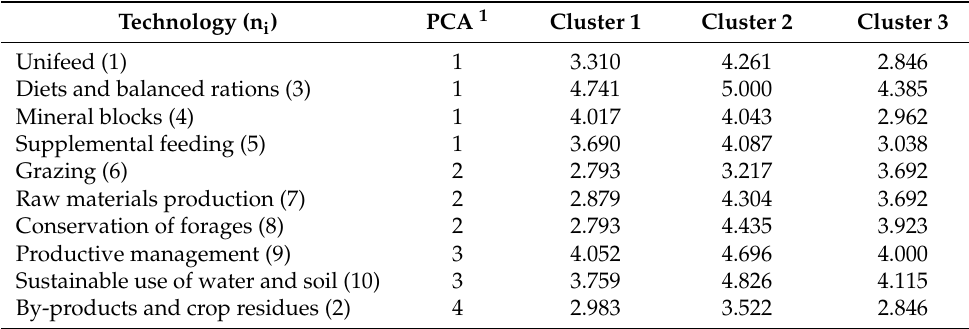
Figure 3. Dendrogram for hierarchical clustering using the Ward’s method and the squared Euclidean distance measure. Table 3. Technologies centroid values for